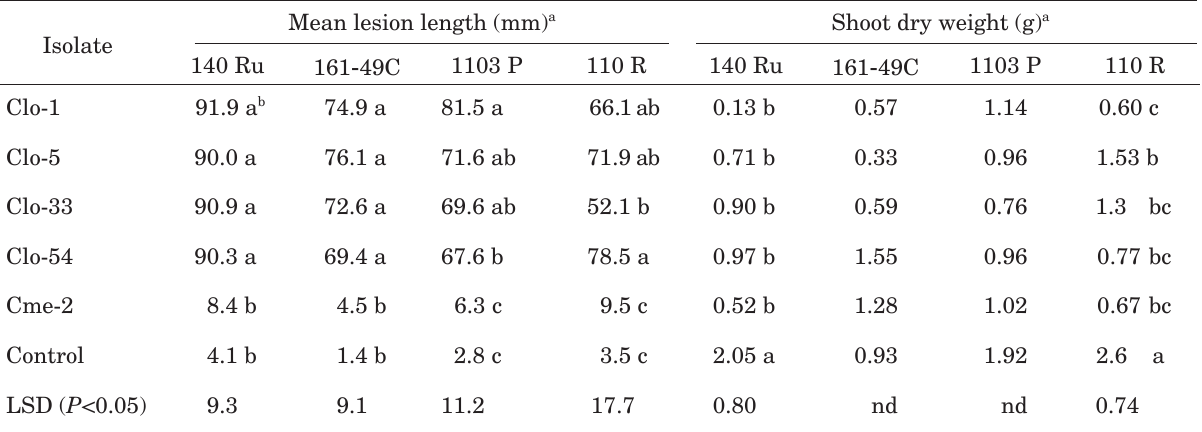
Table 3. Means lesion length and shoot dry weight from grapevine rootstocks 14 weeks after inoculation with C. luteo- olivacea and C. melinii